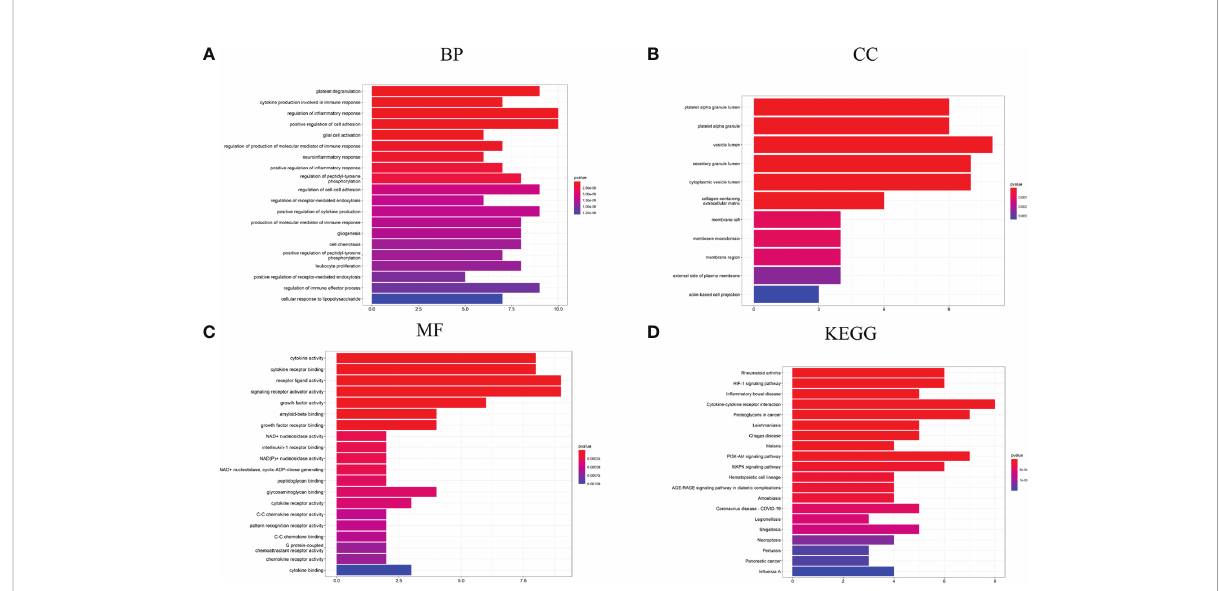
FIGURE 5 GO and KEGG analysis results of Hubgenes. (A) GO biological process enrichment results; (B) GO cell component enrichment results; (C) GO molecular function enrichment results; (D) KEGG pathway enrichment results. GO: gene ontology. KEGG: Kyoto Encyclopedia of Genes and